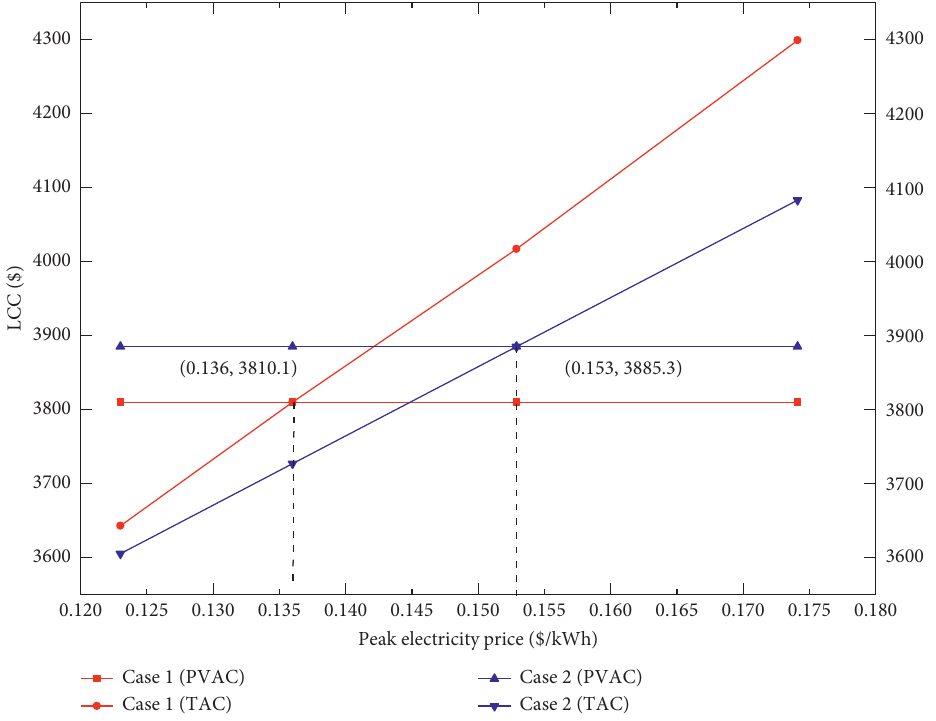
Figure 7: The impact of peak electricity price on LCC of cases 1 and